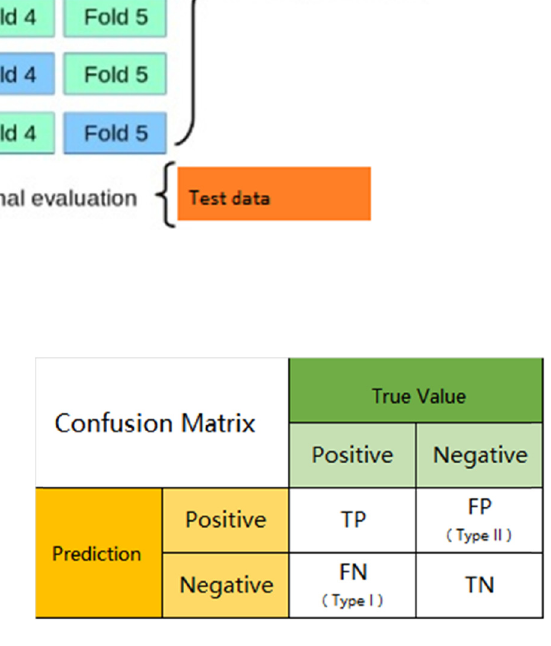
Figure 12: Schematic diagram of confusion